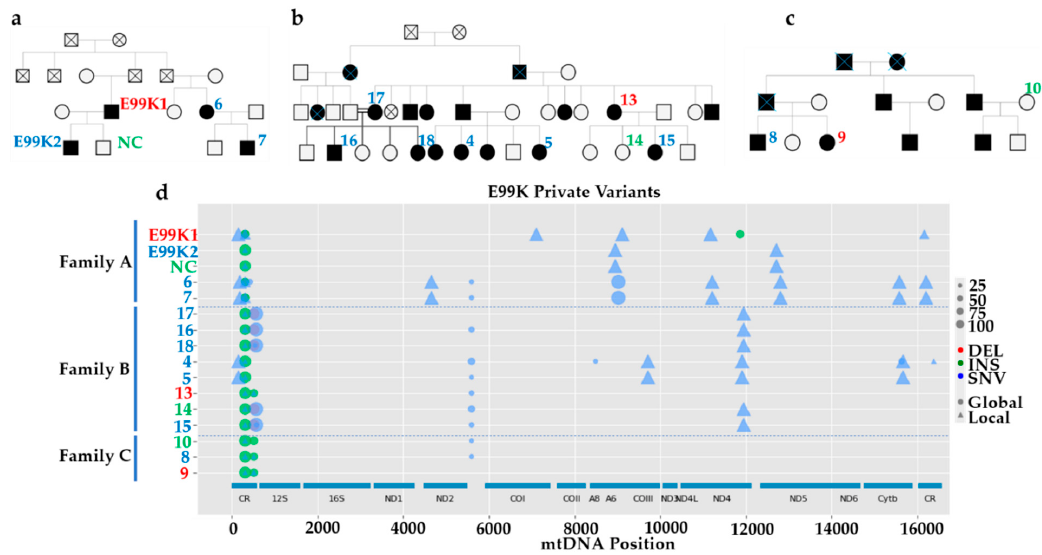
Figure 5. Analysis of mtDNA variants in unrelated HCM patients. ( a – c ) Pedigree chart of three unrelated families where the p.E99K-ACTC1 mutation is common (red numbers indicate more severe phenotypes and green numbers milder ones). ( d ) NGS sequencing analysis of mtDNA of fibroblasts derived from patient skin biopsies identified variants shared between patients or specific to individual families. Legend map on the right side indicates type of mtDNA mutation (DEL, deletion; INS, insertion; SNV, single nucleotide variant) and percent heteroplasmy is correlated with the size